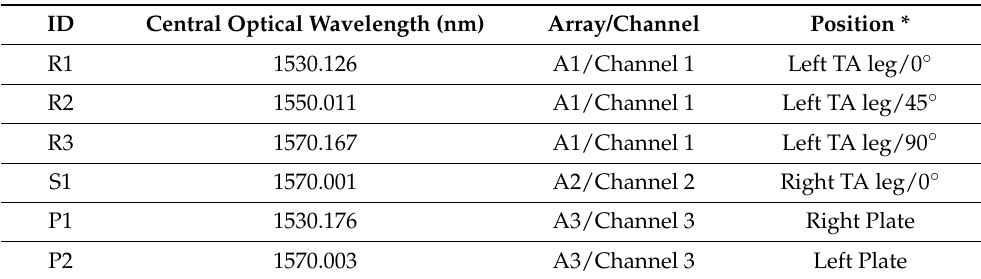
Figure 2. Drop tower with the TA mounted at the impactor. Table 1. Grating arrays